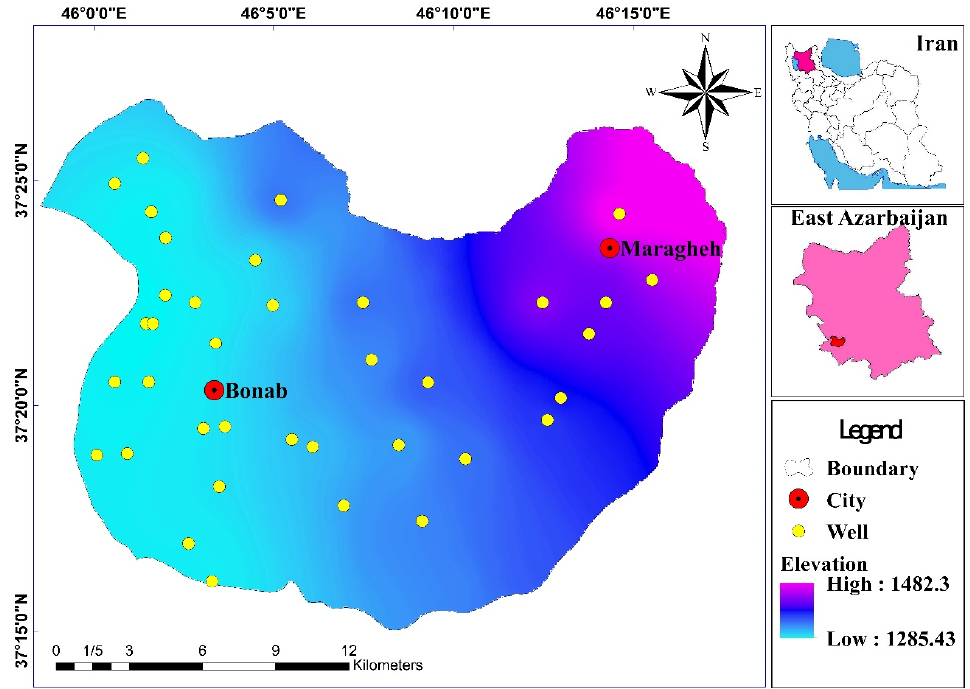
Figure 1. The Maragheh plain in northwestern Iran.